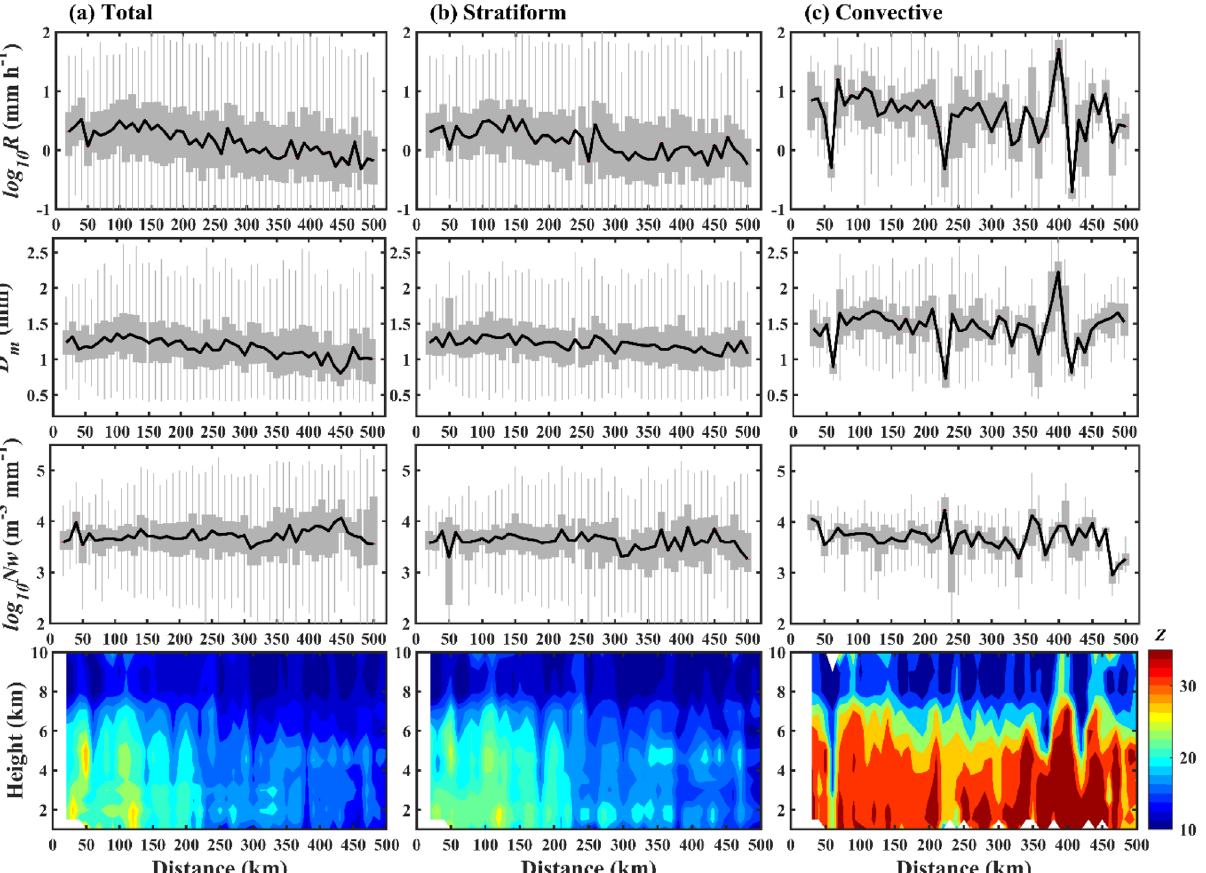
Figure 1. Variations in RSD parameters with radial distance. Distribution of rainfall rate (log 10 R , R is in mm h – 1 ) (first row), mass-weighted mean diameter ( D m , mm) (second row), normalized intercept parameter (log 10 N w , N w is in m –3 mm –1 ) (third row), and vertical profile of mean radar reflectivity (Z, dBZ) (fourth row) with radial distance (every 10 km) for all category TCs’ ( a ) total, ( b ) stratiform, ( c ) convective rainfall. RSD parameters in first three rows are displayed with box plots. The gray areas in first three rows denote the 25th–75th percentile of the RSD parameters, and the black solid lines denoted the median values at every 10